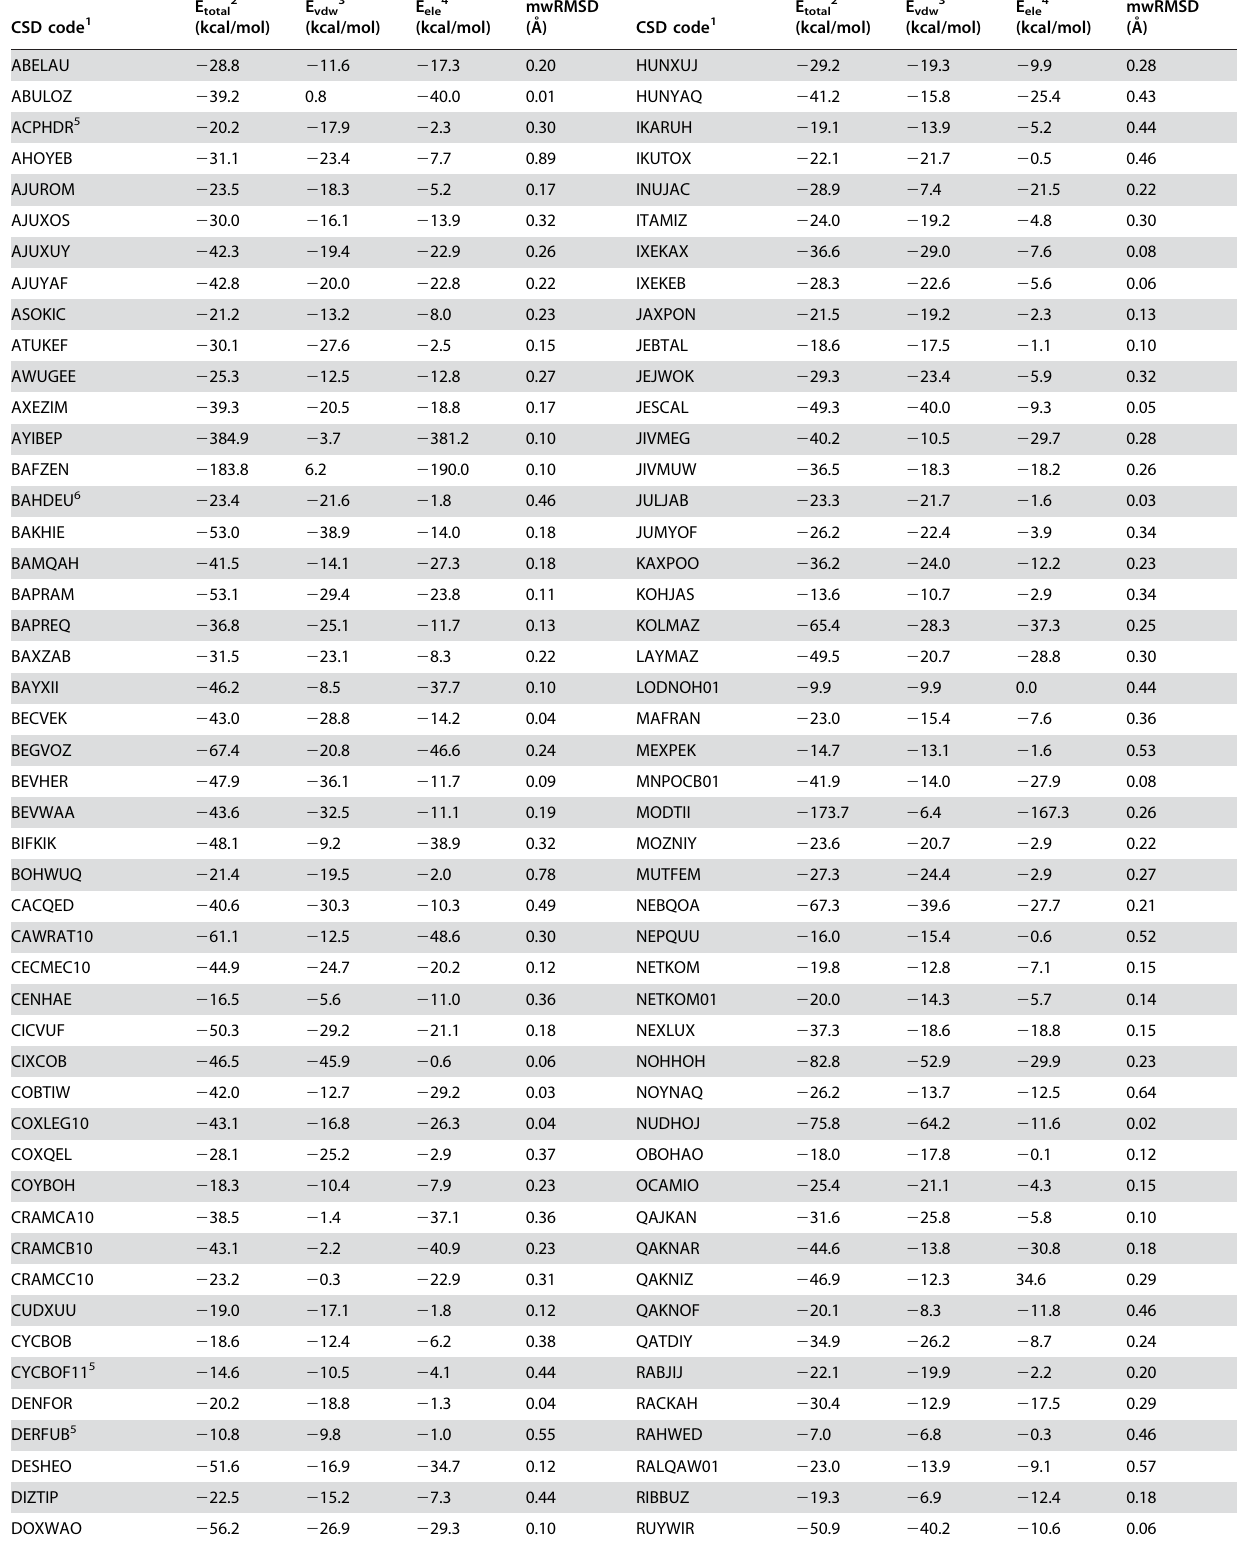
Table 3. The intermolecular interaction energies of the 161 small-molecule complexes generated by the EUDOC program and their mass-weighted root mean square deviations (mwRMSDs) relative to their corresponding crystal structures. .. ... .... ... ... .... ... ... .... ... ... .... ... ... .... ... ... .... ... ... .... ... ... .... ... ... .... ... ... .... ... ... .... ... ... .... ... ... .... ... ... .... ... ... . CSD code